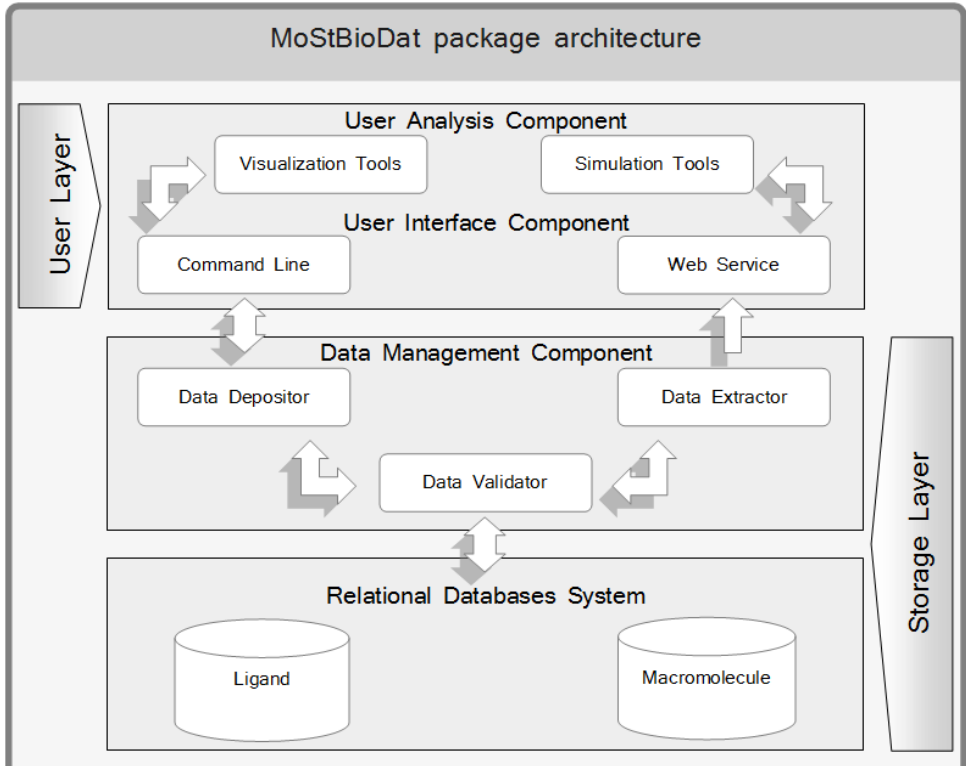
Figure 1. The architecture of the MoStBioDat